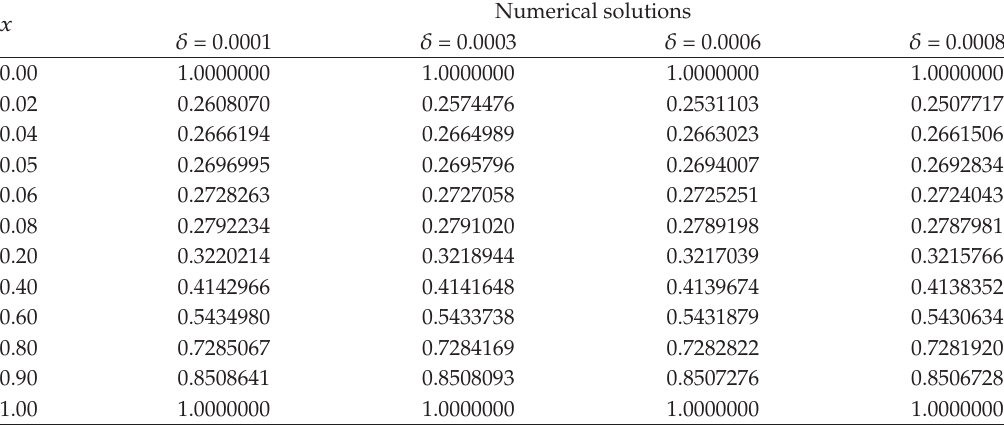
Table 5: Numerical results of Example 4.2 for ε (cid:8) 0 . 001, N (cid:8) 100, and di ff erent values of δ